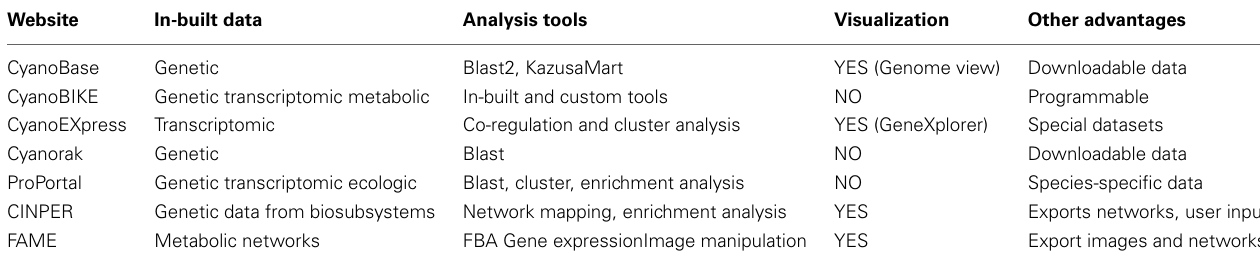
Table 2 | Web-based analytical tools with a specific focus on cyanobacteria as at April 2014.